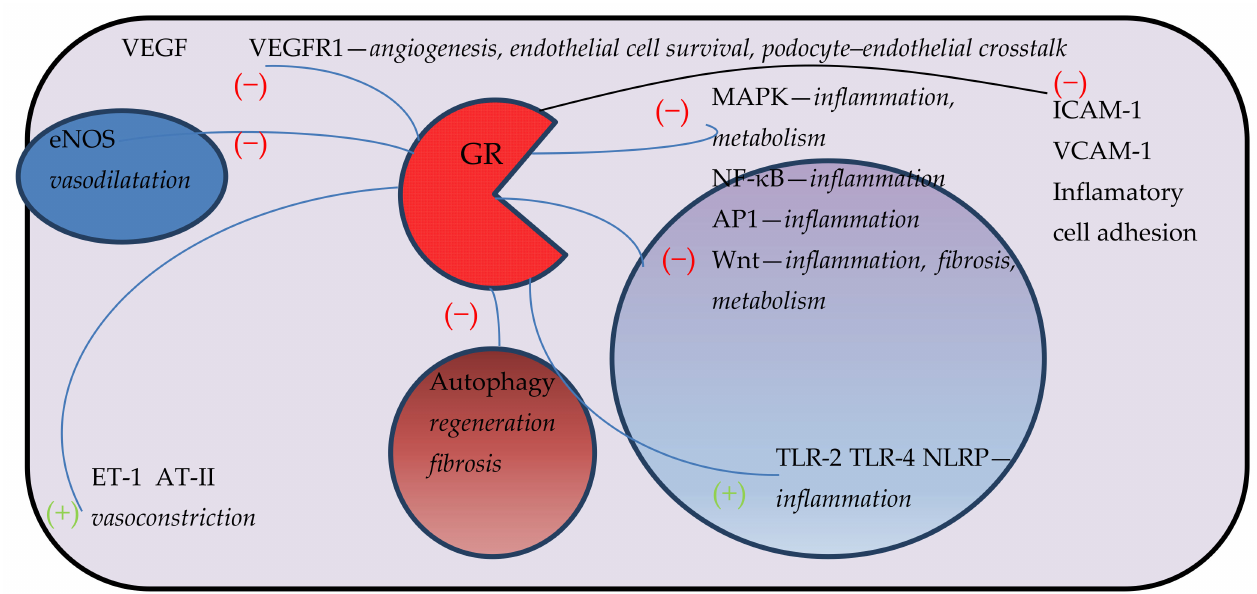
Figure 1. Selected effects of GR signalling in endothelial cells and its implication in kidney health and disease. Effect of GR signalling on various aspects of endothelial cell function showing inhibition of proinflammatory MAPK, NF- κ B, AP1 and Wnt pathways as well as effect on vascular tone and VEGF-VEGFR1. “( − )” representing inhibition and (+) stimulatory effect. GCs lead transrepression of inflammatory genes such as NF- κ B or AP-1 in endothelium. GR stimulation activates MPK-1 phosphatase and inhibits MAPK pathway and E-selectin expression. GCs can induce TLR 2 and 4, and NLRP3 genes. GCs can reduce VEGF and VEGF receptor 1 (VEGFR1) protein expression through the mTORC1 pathway. GR stimulation is associated with inhibition of the Wnt/ β -catenin pathway. GCs can increase the secretion of ET-1 and AT-2 from ECs. GCs directly reduce eNOS transcription through GATA interaction. GCs reduce expression of adhesion molecules on endothelial cells. VEGF—vascular endothelial growth factor, VEGFR-1—vascular endothelial growth factor receptor 1, eNOS—endothelial nitric oxide synthase, ET-1—endothelin 1, AT-II—angiotensin II, MAPK—mitogen activated protein kinases, NF- κ B—nuclear factor kappa B, AP1—activator protein 1, Wnt—Wnt signalling pathway, TLR—Toll-like receptor, NLRP—nuclear binding oligomerization domain, GR—glucocorticoid receptor, ICAM-1 intracellular adhesion molecule 1, VCAM-1—vascular cell adhesion